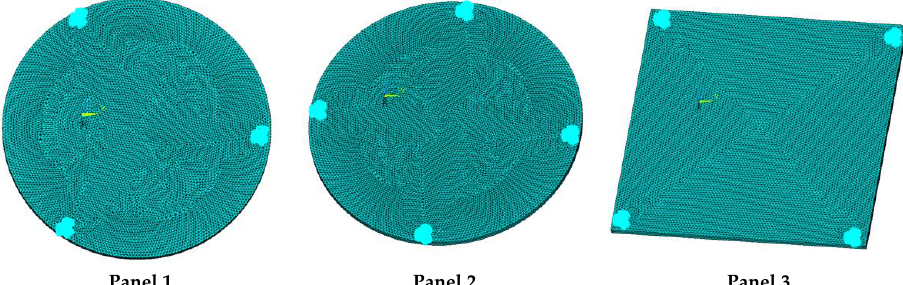
Figure 9. The three basic configurations of the work panel.